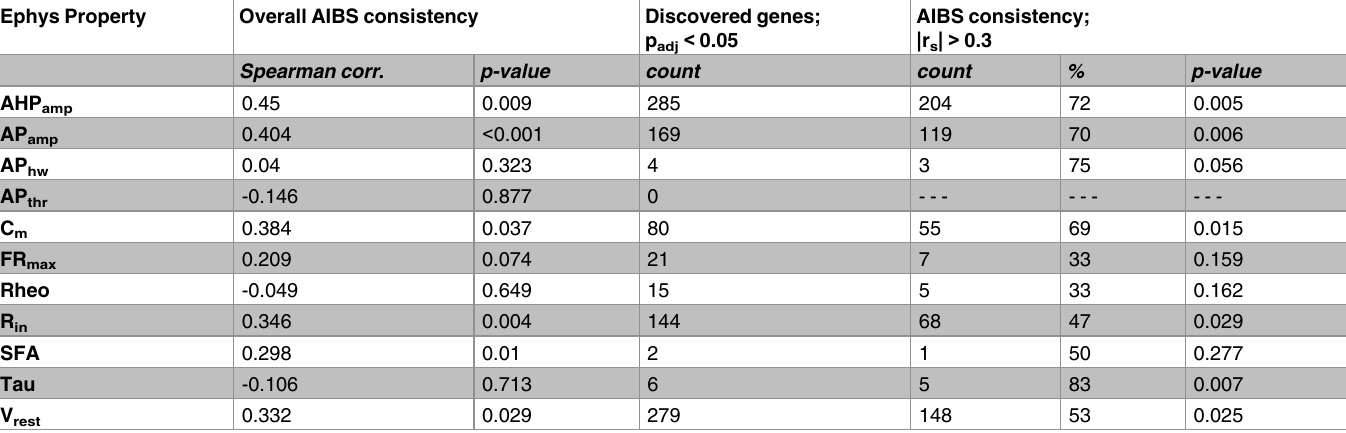
Table 3. Consistency of gene-electrophysiological property correlations between NeuroExpresso/NeuroElectro discovery and AIBS validation datasets. Overall AIBS consistency indicatesoverall Spearman rank correlationbetweenthe full set of gene-electrophysiological correlationscalculatedin both the discovery and validationdatasets, as shown in Fig 2 B. P-values based on 1000random reshuffles of cell type labels in the AIBS validation dataset. Discovered genes, p adj < 0.05 reflects count of genes significantly correlatedwith each ephys property with in discovery dataset (only includesgenes that are also present in AIBS scRNAseqdataset). AIBS consistency, |r s | > 0.3 reflects count and percentage of discoveredgenes that further show a consistent rela- tionshipin the AIBS validationdataset. P-value also based on 1000 shuffled samples of cell type labels in the